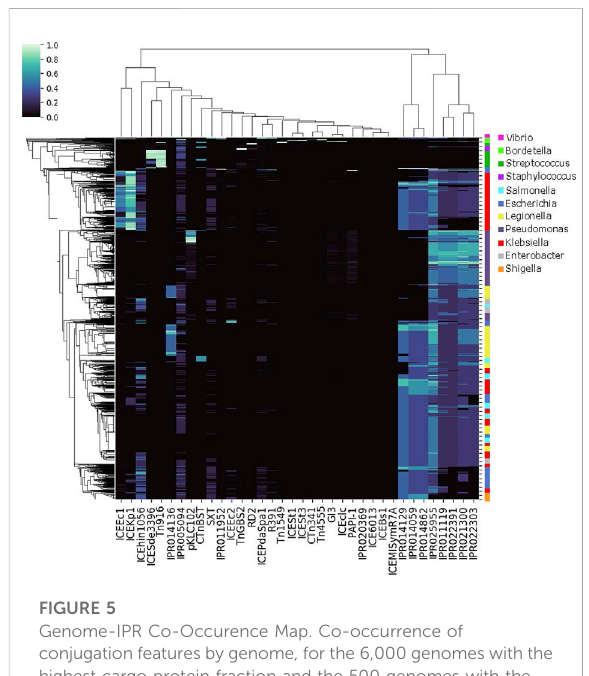
FIGURE 5 Genome-IPR Co-Occurence Map. Co-occurrence of conjugation features by genome, for the 6,000 genomes with the highest cargo protein fraction and the 500 genomes with the rarest conjugation features (see text). Co-occurrence of particular conjugation features does vary by taxonomic